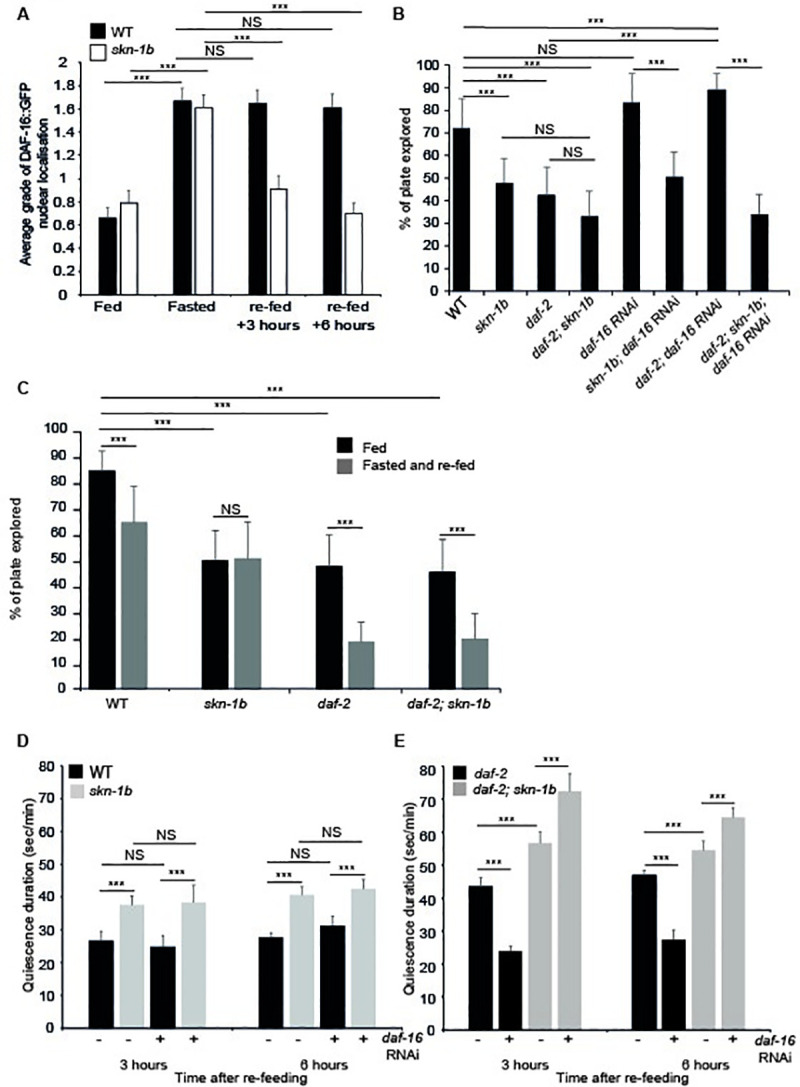
SKN-1B regulates IIS to control behaviour.A) Quantification of nuclear localisation, WT and skn-1b worms expressing ges-1p::GFP::daf-16 [62], average grading shown. Grading system and total % of worms in each grade (S9 Fig). Combined data from 3 biological replicates shown ± SEM, n>48 worms per group. B) Quantification of exploration. One representative of 3 biological replicates shown ± st. dev., n>10 worms per group. C) Quantification of exploration in fed vs fasted and re-fed conditions. Worms fasted for 1hr. One representative of 3 biological replicates shown ± st. dev., n>35 worms per group. B and C) Similar findings were obtained using daf-2(e1368) (S11A and S11B Fig). D and E) Time spent in quiescence after fasting and re-feeding. Each bar represents a mean of 3 biological replicates ± SEM, total of n>36 worms per group. For C-E) Similar numbers of worms from each group were observed in quiescence (S6D–S6F Fig). For A-E: Two-tailed t-test *p<0.05, **p< 0.001, ***p<0.0001, NS = not significant.